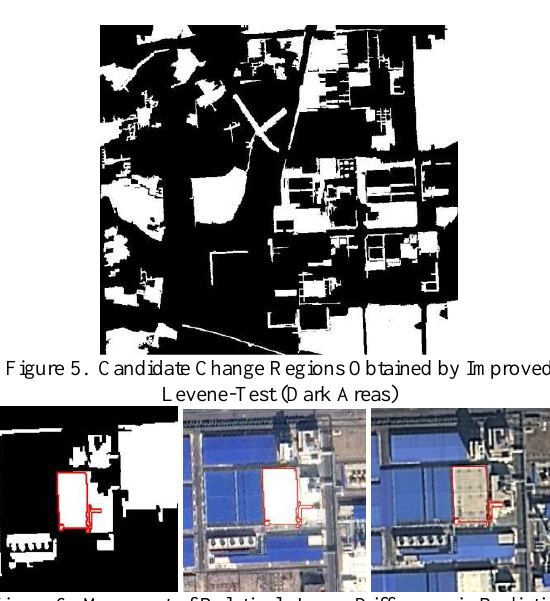
Figure 6. Map-spot of Relatively Large Difference in